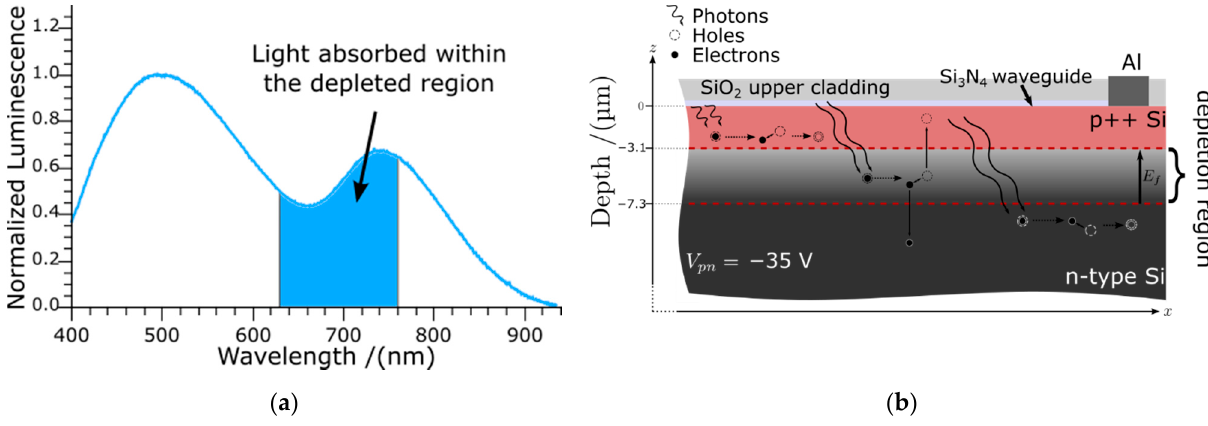
Figure 10. (a) PL Spectrum of II-SRO. The shadowed portion of the spectrum is what can be absorbed within the depletion region of a p-n photodiode with the parameters detailed in Reference [25] at V pn = − 35 V; (b) schematics of the process of light absorption, e-h pair generation, and separation in the depletion region for a p-n diode with the fabrication parameters as detailed in Reference [25].